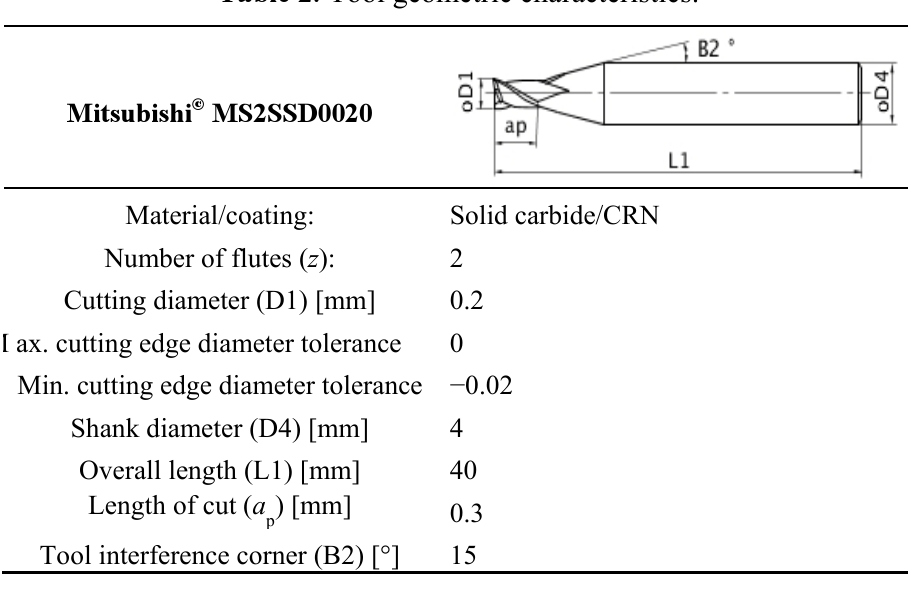
Figure 7. Set up on KERN clamp.